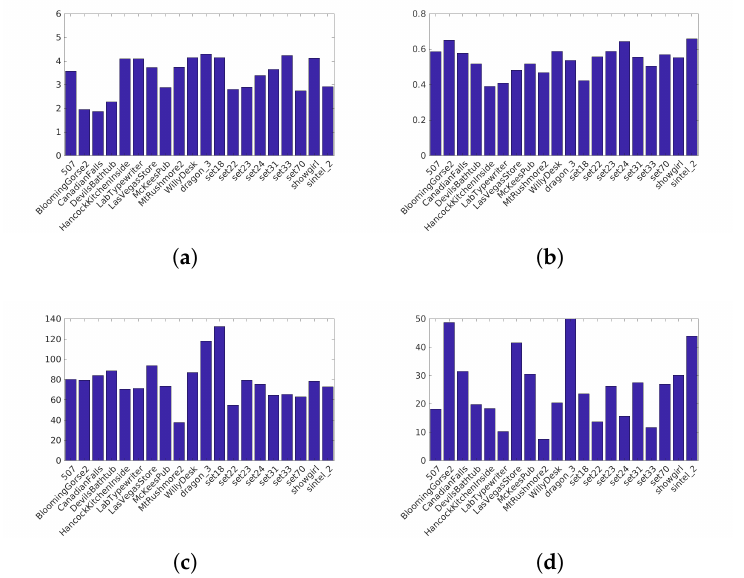
Figure 4. Characteristics of the Korshunov et al. [35] images: ( a ) The dynamic range, ( b ) key, ( c ) spatial Information, ( d )